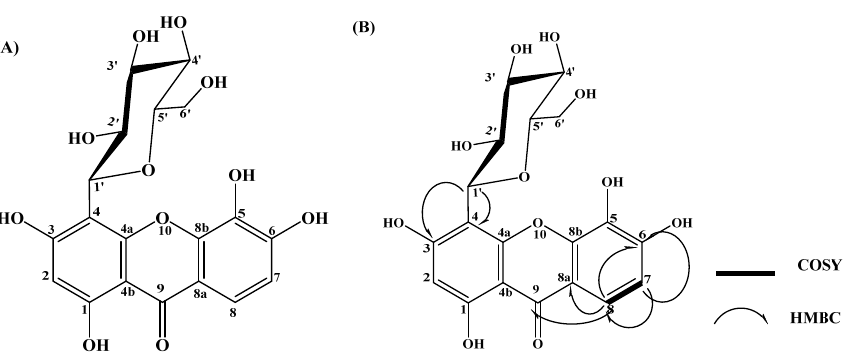
Figure 1. Chemical structure. ( A ) HMBC and 1 H, 1 H-COSY correlations ( B ) of isolated compound.